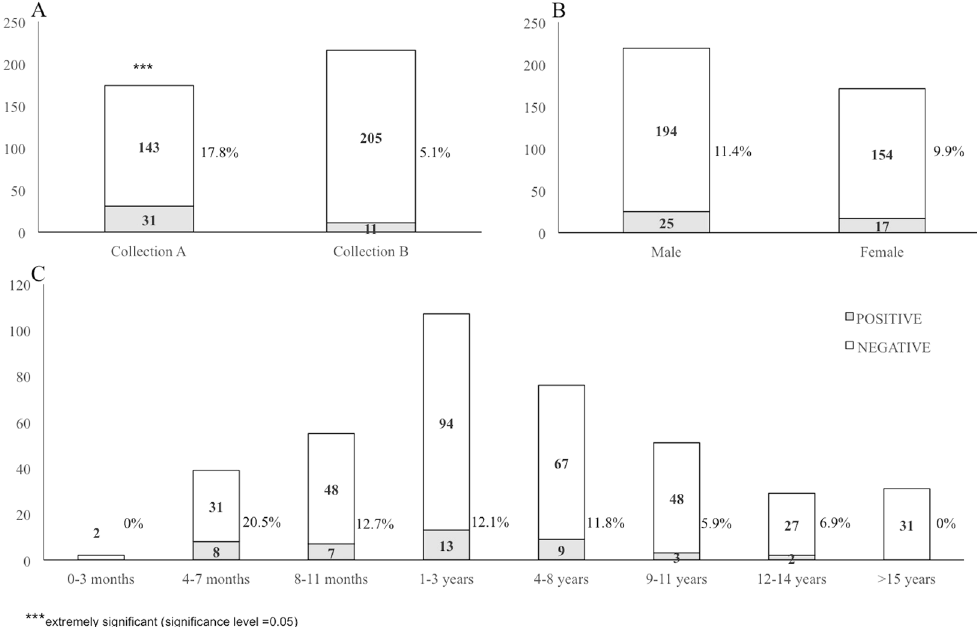
Figure 1. Results of the screening for DCH in the feline sera. The prevalence of DCH was evaluated in sera collected for the diagnosis of infectious diseases (collection A ) and sera submitted to the laboratory for pre- surgical evaluation or for suspected metabolic or neoplastic disease (collection B ) and used for comparison (panel A). The prevalence of DCH was also evaluated in relation to sex (panel B) and age (panel C) of the